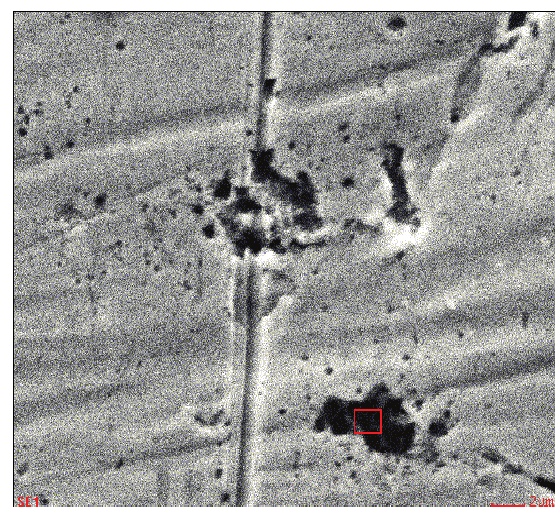
Figure 8. Scanning electron micrograph showing pits on stainless steel 304L exposed to inoculated Baar’s media in 50 day’s immersion test.